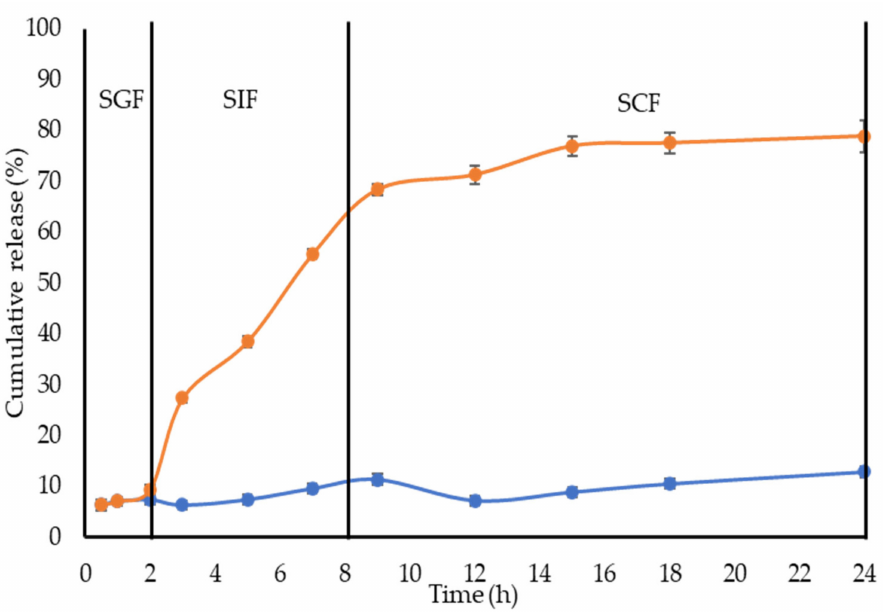
Figure 5. Gastrointestinal-simulated cumulative release profiles of CL ( • ) and CL from CL-loaded NBSCh micelles ( • ) in SGF pH 1.2 (0–2 h), followed by SIF pH 6.8 (2–8 h) and finally in SCF pH 7.4 (8–24